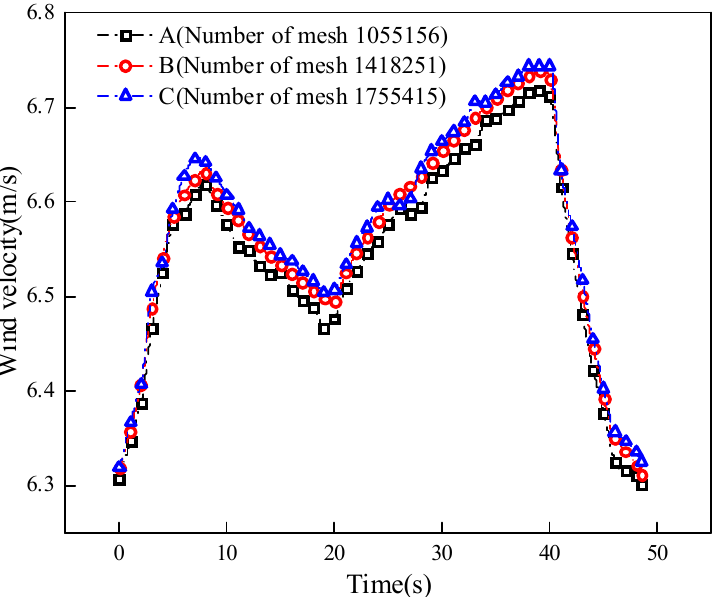
Figure 3. Time-varying curve of wind speed at the outlet of 1584.0 m transport lane with different mesh schemes.